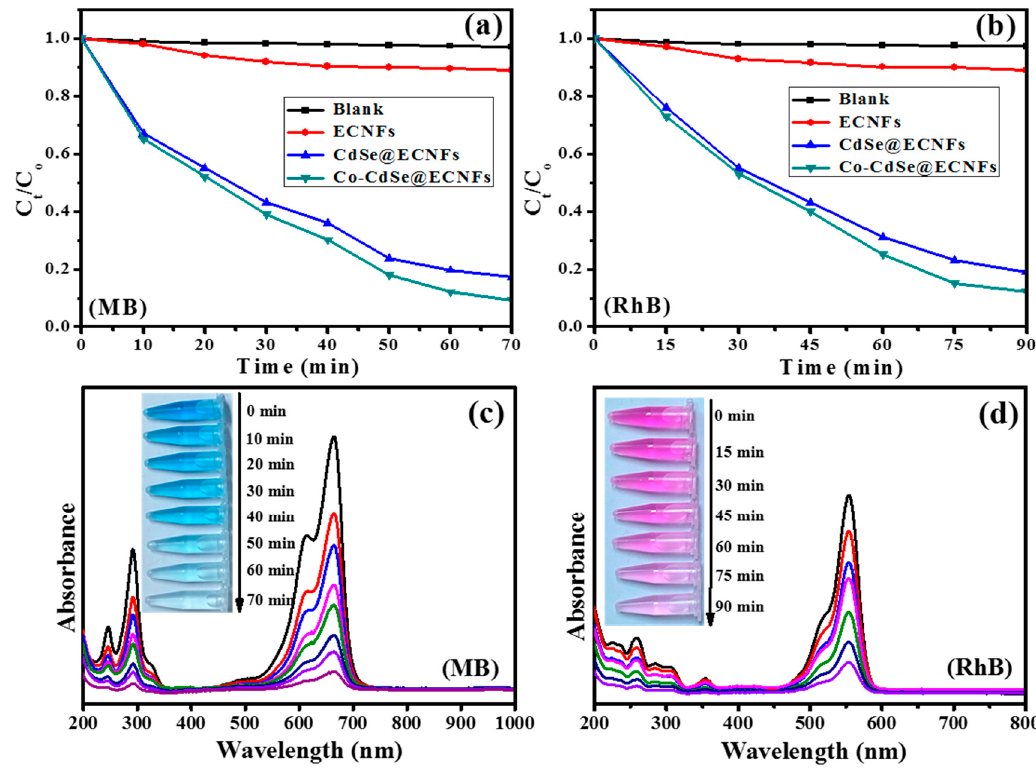
Figure 9. Photocatalytic performance of ECNFs, CdSe@ECNFs, and Co-CdSe@ECNFs towards the photodegradation of ( a ) methylene blue (MB) and ( b ) rhodamine B (RhB) solutions. The absorbance variation of ( c ) MB and ( d ) RhB solutions utilizing Co-CdSe@ECNFs. Insets: digital photographs showing gradual change in the color of corresponding dye solution with irradiation time.